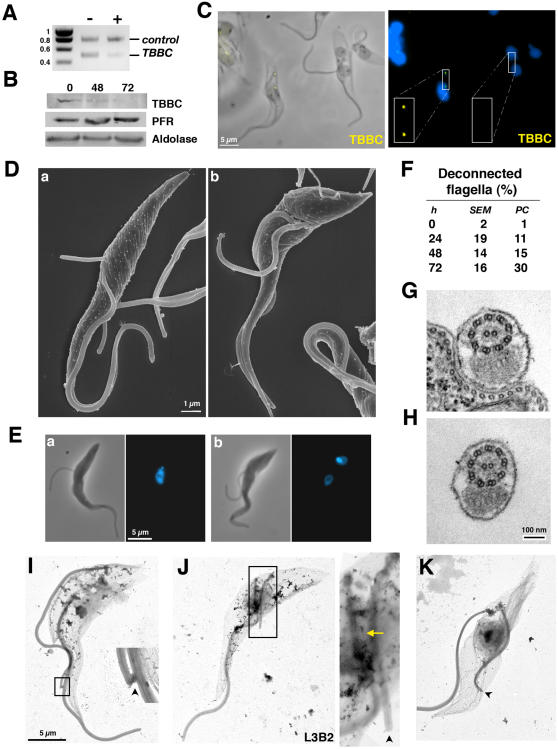
TBBC is necessary for flagella connection.A. RT-PCR using TBBC and aldolase primers demonstrates specific TBBC RNA silencing as described at Fig. 1A. B. Western blot analysis of TBBCRNAi cells grown with tetracycline for the indicated periods of time. The same membrane was probed with antibodies against the indicated proteins. C. Immunofluorescence of TBBCRNAi cells induced for 72 h with the anti-TBBC antibody (yellow) stained with DAPI (blue) showing two bi-flagellated cells, one with normal TBBC staining (left) and one without labelling (right, see insets). Lack of flagella connection is exclusively observed in the latter category. D. Scanning electron micrograph of bi-flagellated cells from TBBCRNAi cells induced for 48 h. The tip of the new flagellum is free and the flagellum is detached at early (a) and late (b) stages of elongation. E. Glutaraldehyde fixation of similar cells coming from the same population but analysed after DAPI staining. F. The proportion of cells with a deconnected and detached new flagellum (n = 100) during the course of induction (analysed by scanning electron microscopy [SEM] or phase contrast optics [PC]). G–H. Cross-sections of attached (G) or detached (H) flagella from TBBCRNAi cells induced for 72 h revealing similar ultra-structural organisation. I–K. Detergent-extracted cytoskeletons of 72h-induced TBBCRNAi cells. When the new flagellum is still connected to the old (I), a clear FC structure is visible (arrowhead). By contrast, no FC is recognised when the new flagellum is not connected, no matter flagellum length (J–K). J. L3B2 staining revealing interactions between old and new FAZ (yellow arrow).